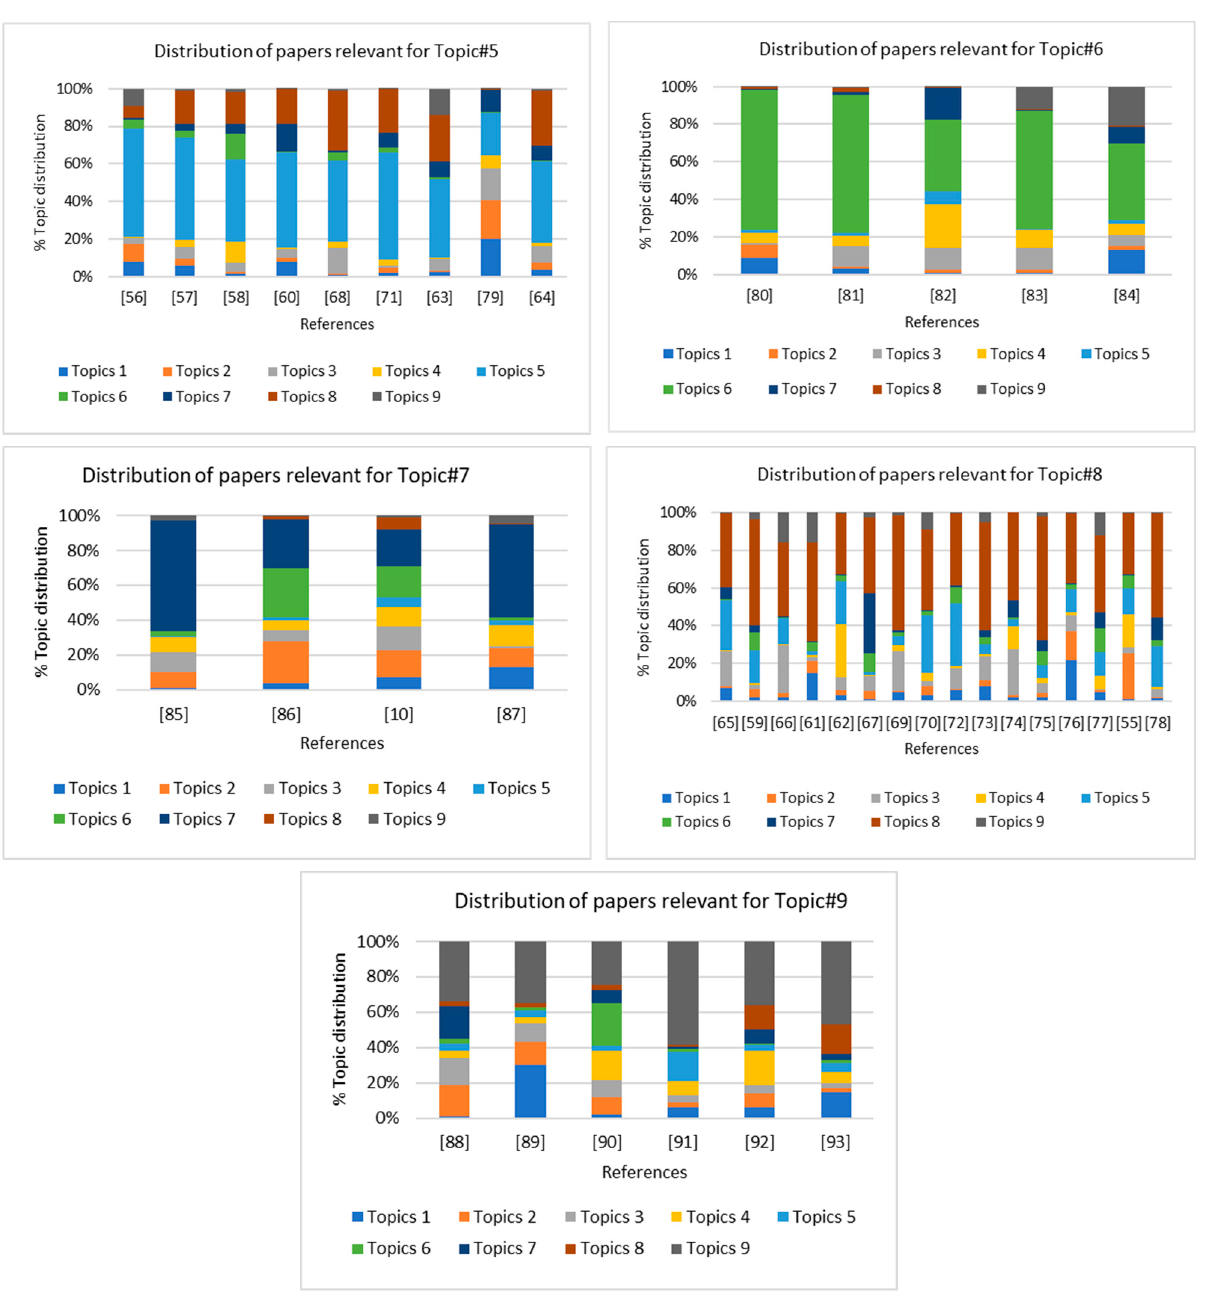
Figure 5. Topics distribution over papers.